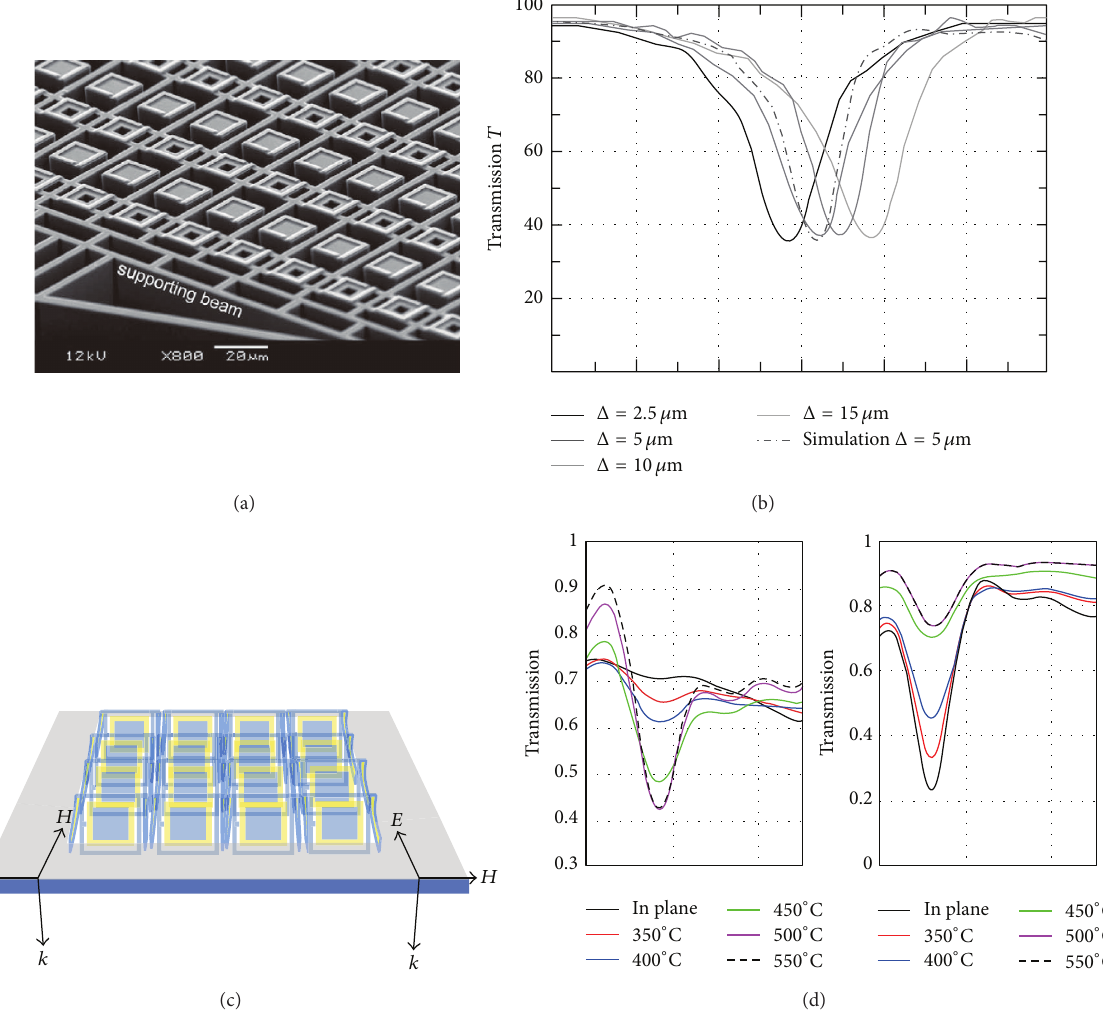
Figure 39: Examples of active metasurfaces. (a) SEM image (b) transmission spectra for a MEMS-based metasurface. (c) Schematic and (d) transmission spectra for magnetic resonance (left panel) and electric resonance (right panel). Figures are reproduced from [219,